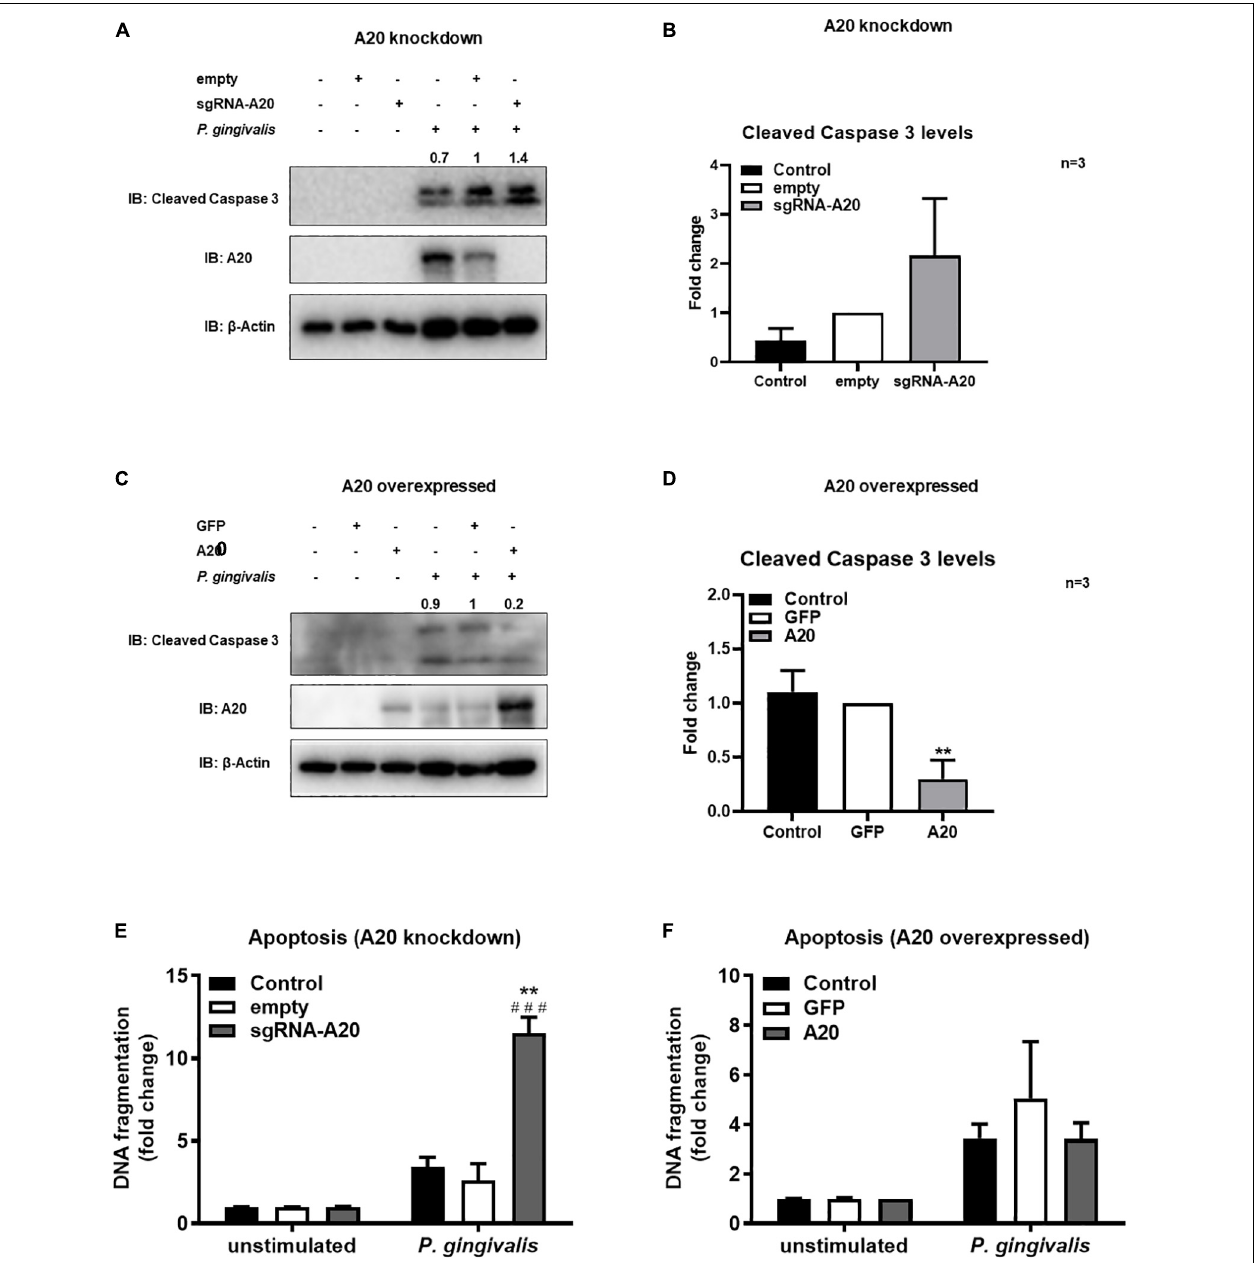
FIGURE 7 | A20 restricts apoptosis in gingival keratinocytes following P. gingivalis infection. Western blots detecting cleaved caspase 3 levels in TIGKs with altered A20 expression or control cells with P. gingivalis infection. Representative blots of cleaved caspase 3 levels in TIGKs with control or A20 knock-down (A) and A20 over-expression (C) infected with P. gingivalis (100 MOI) for 24 h. Relative density of cleaved caspase 3 levels from three independent experiments were plotted with mean and standard errors (B,D) . ** P. gingivalis infected A20 overexpressed cells compared to infected controls ( P ≤ 0.01). ELISA detecting cytoplasmic histone associated DNA fragments in TIGKs. A20 depleted and control cells (E) , or A20 over-expressing cells and control cells (F) were infected with P. gingivalis for 24 h and applied to Cell Death Detection ELISA. Each experiment was performed three times and representative experiments were shown. ### Unstimulated cells versus corresponding P. gingivalis infected cells ( P ≤ 0.001); ** P. gingivalis infected A20 depleted cells compared to infected controls ( P ≤